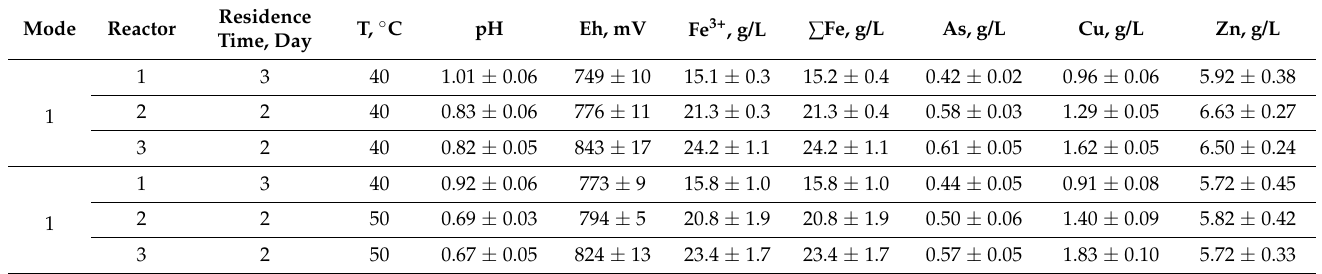
Table 2. Average values of liquid phase parameters during bioleaching experiments (steady state conditions).